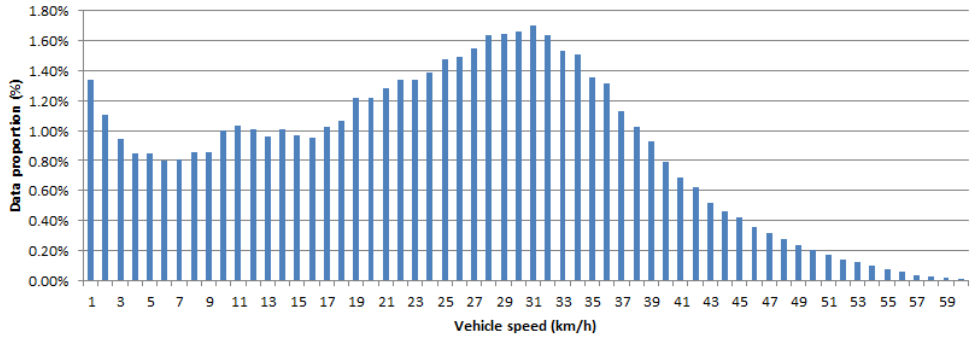
Figure 3. Distribution of the vehicle speed (km/h) in analytical data.